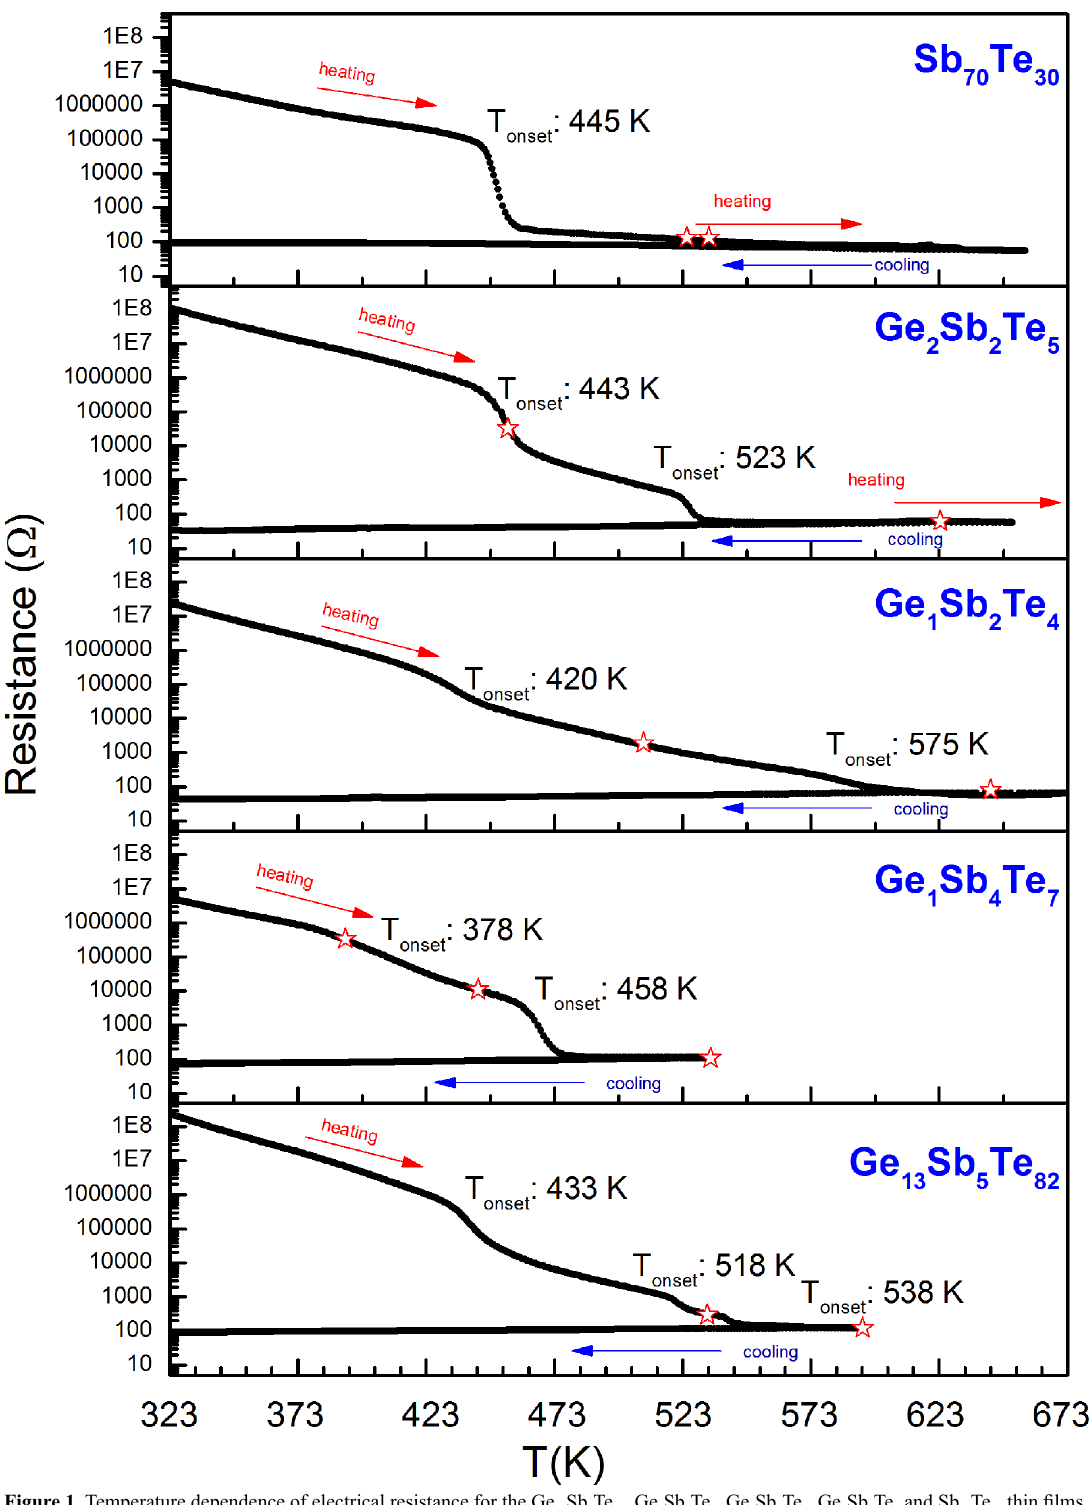
Figure 1. Temperature dependence of electrical resistance for the Ge Each red star shows the maximum temperature reached by a sample before an X-ray diffraction experiment was held at room